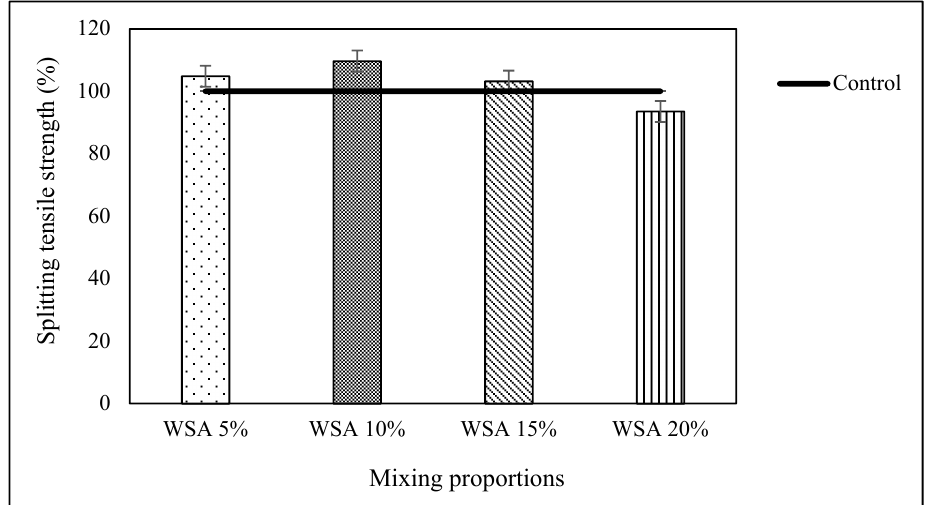
Figure 5. Relative splitting tensile strength of conventional concrete and concrete with wheat straw ash and mixing proportions of concrete.